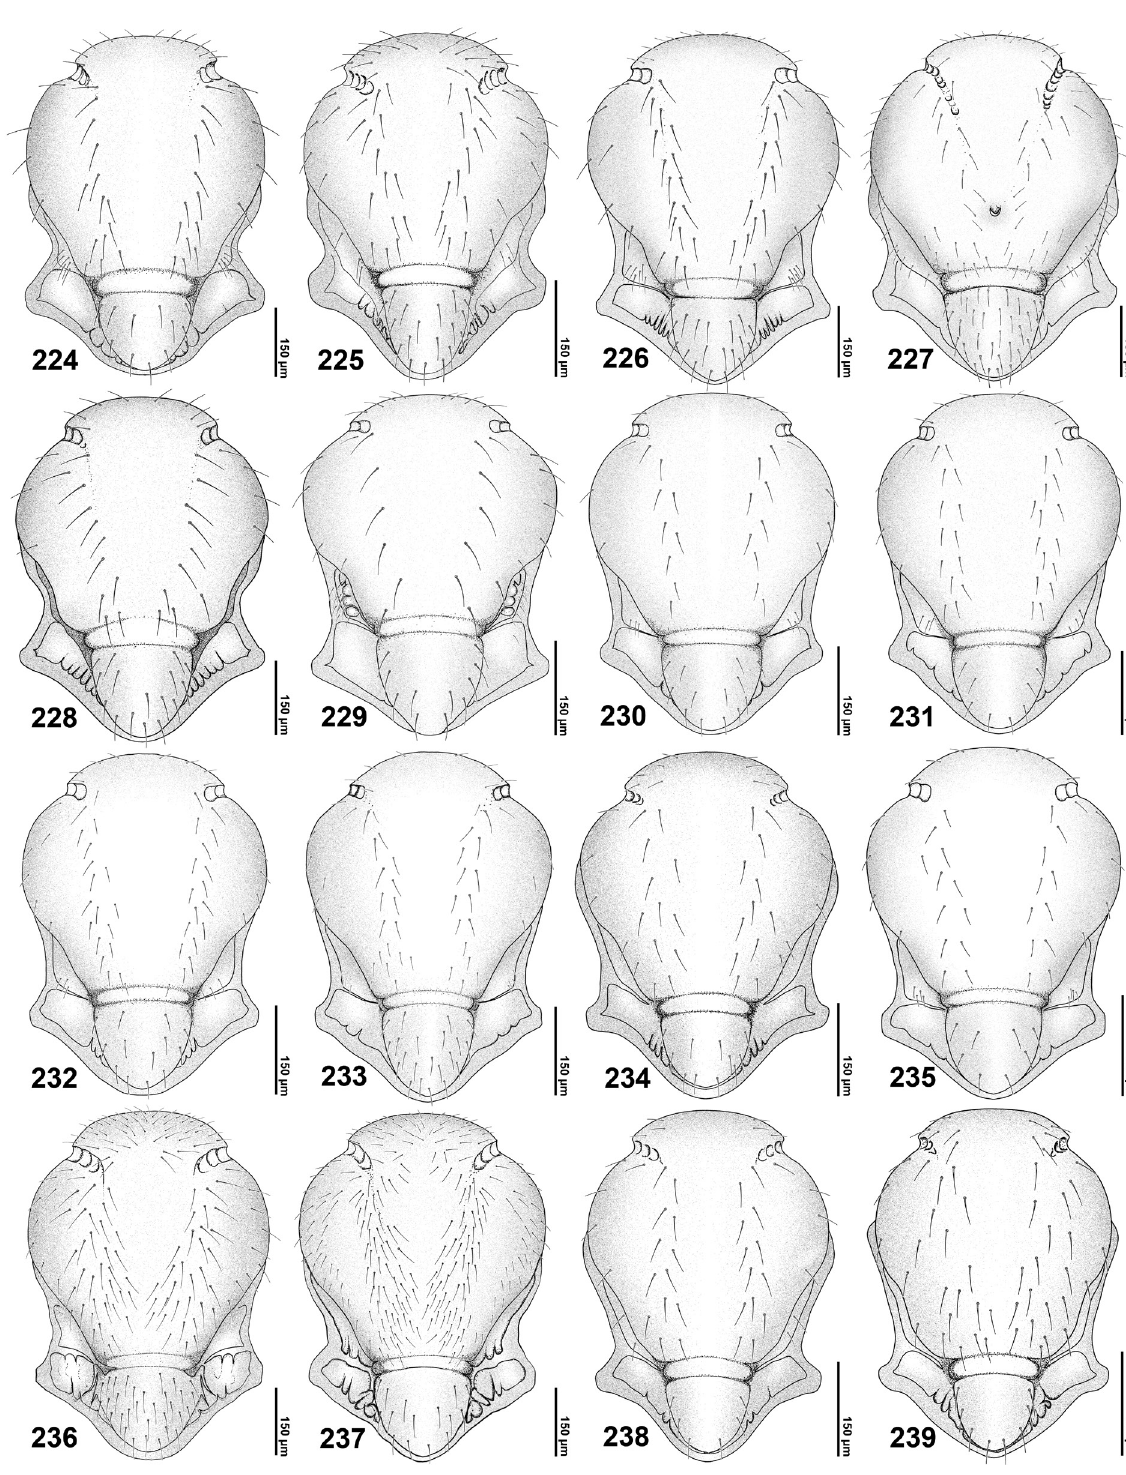
Figs 224–239. Dorsal aspect of mesonotum (♀): 224 . Ephedrus lacertosus . 225 . Ephedrus nacheri . 226 . Ephedrus niger . 227 . Ephedrus persicae . 228 . Ephedrus plagiator . 229 . Lipolexis gracilis . 230 . Lysiphlebus cardui . 231 . Lysiphlebus confusus . 232 . Lysiphlebus desertorum . 233 . Lysiphlebus fabarum . 234 . Lysiphlebus fritzmuelleri . 235 . Lysiphlebus testaceipes . 236 . Monoctonia pistaciaecola . 237 . Monoctonia vesicarii . 238 . Monoctonus crepidis . 239 . Monoctonus mali